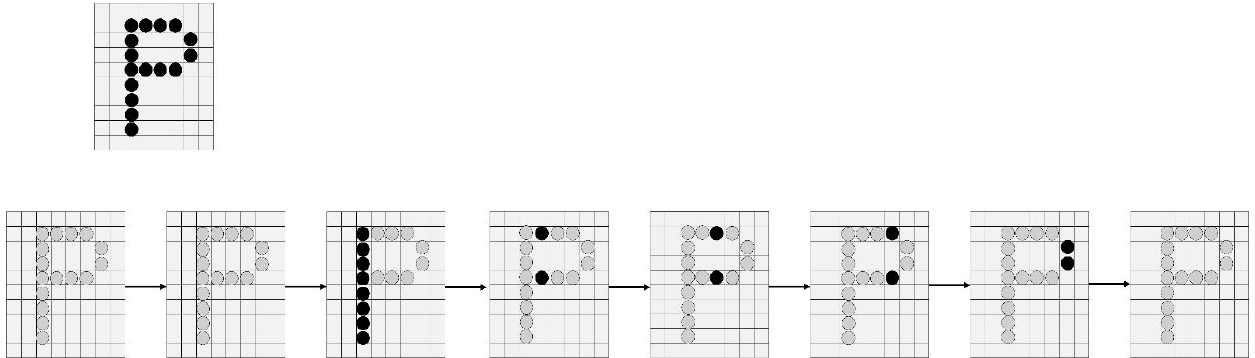
Figure 13. Diagram showing the sequence of driving the vibrator rows at 100 ms intervals. In this example, the letter “P” is presented.